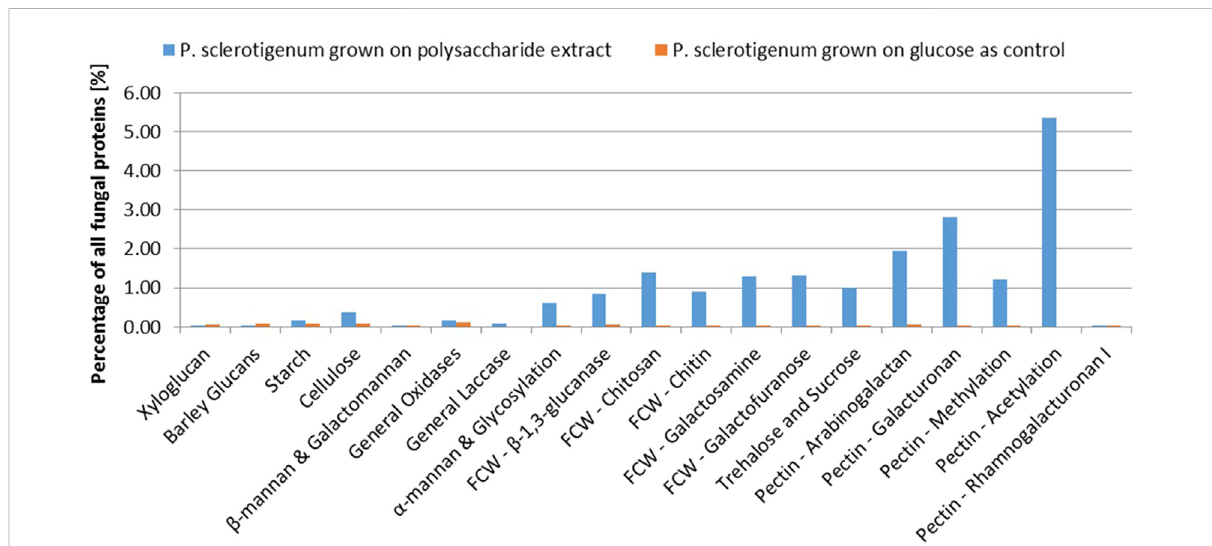
FIGURE 3 Abundance of each CAZyme category given as a percentage of the total protein content detected in the exo-proteome of P. sclerotigenum . The blue bars represent the abundance in the presence of the pectin-rich fraction, whereas the small orange bars to the right indicate the corresponding abundances in the reference grown on glucose. Pre fi x FCW indicates a suggested Fungal Cell Wall component target.